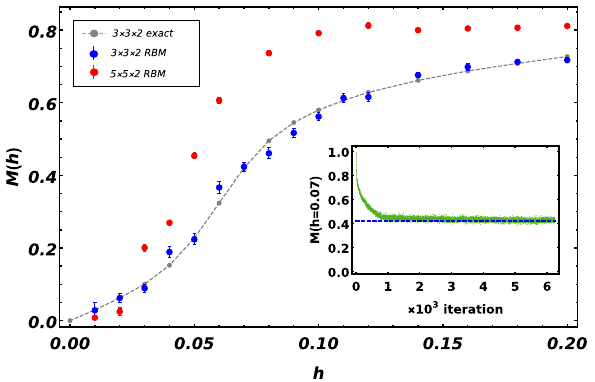
Figure 7. Magnetization M ( h ) computed as a function of the magnetic field h . Exact values obtained by exact diagonalization (gray solid circle) are compared. The inset shows the convergence of magnetization at h = 0.07 for N = 3 × 3 × 2 lattice towards to the exact value (blue dashed line) in the training process. Parameters: J x = J y = J z = 2 .